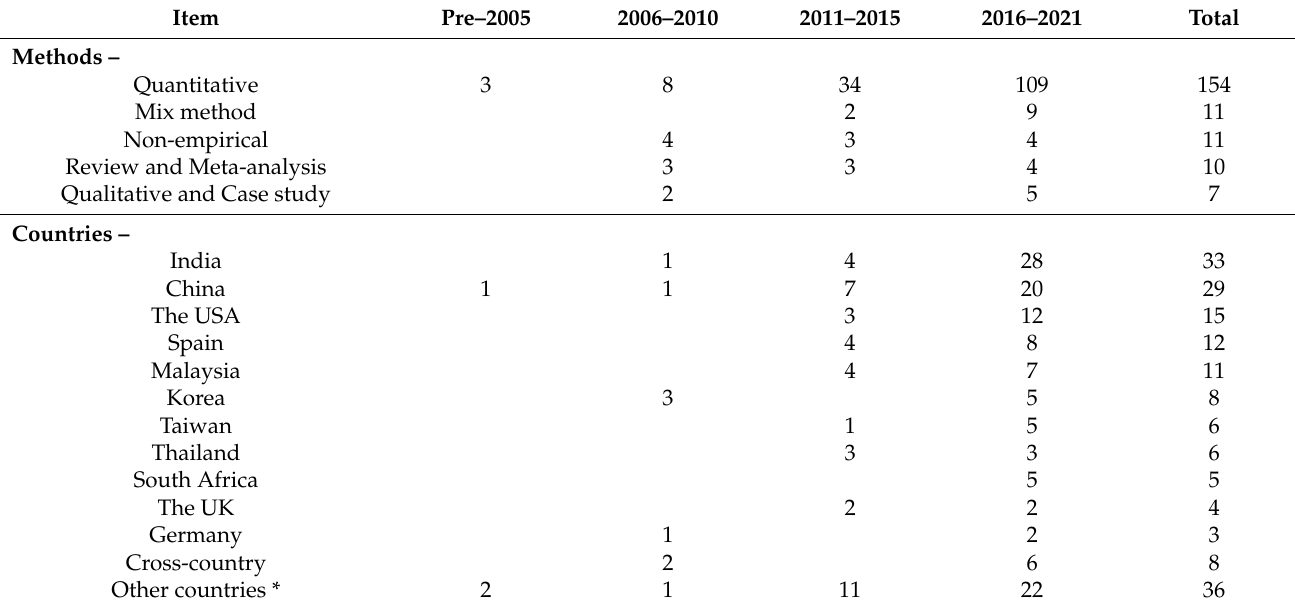
Table 2. The research settings of the prior